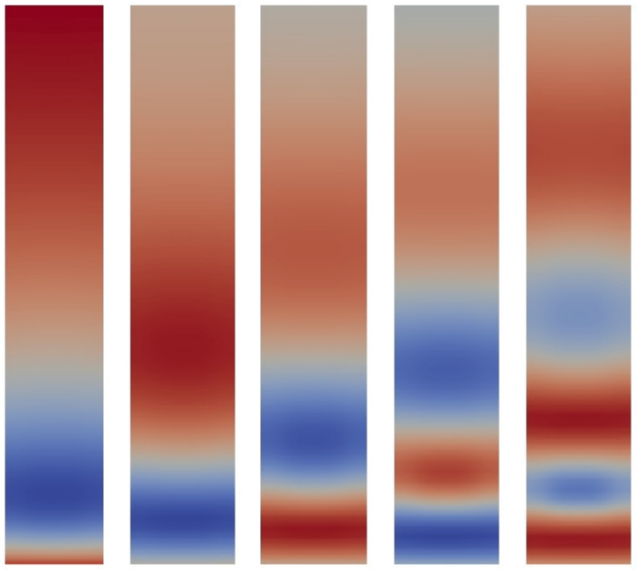
Figure 5. The first 5 Proper Orthogonal Decomposition (POD) basis functions for the group 2 scalar flux. (View of the xz plane with scaling applied in z